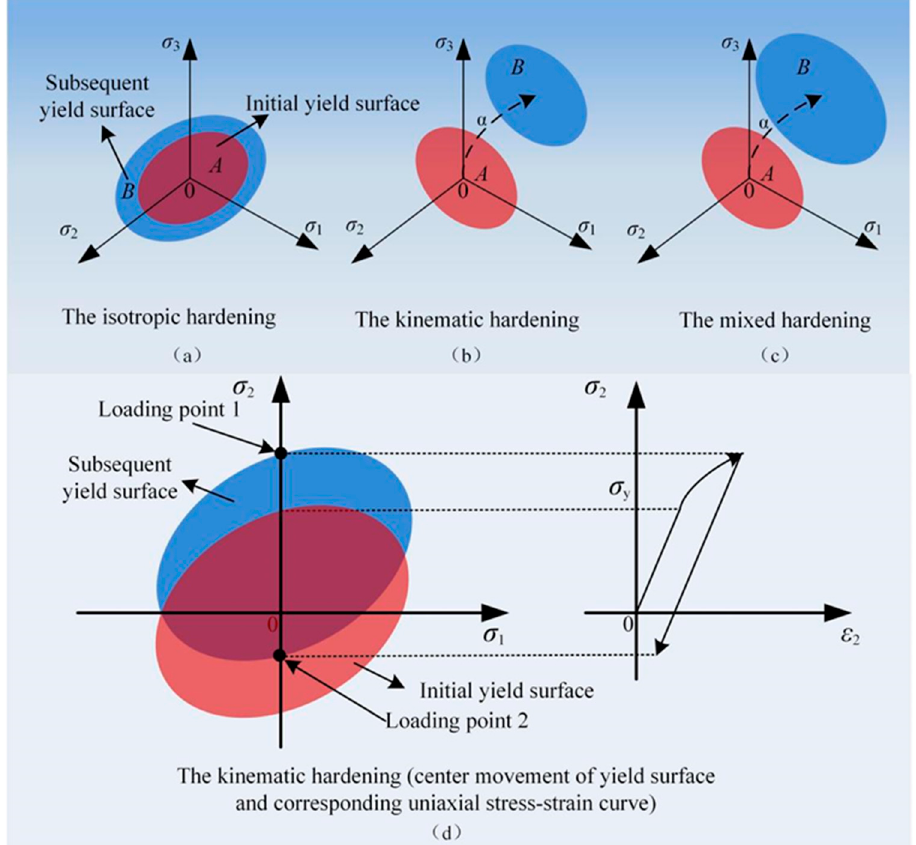
Figure 1. Schematic diagram of yield surface variation in the classic hardening theories: ( a ) isotropic hardening model; ( b ) kinematic hardening model; ( c ) combined hardening model; ( d ) kinematic hardening (center movement of yield surface and corresponding uniaxial stress–strain curve).